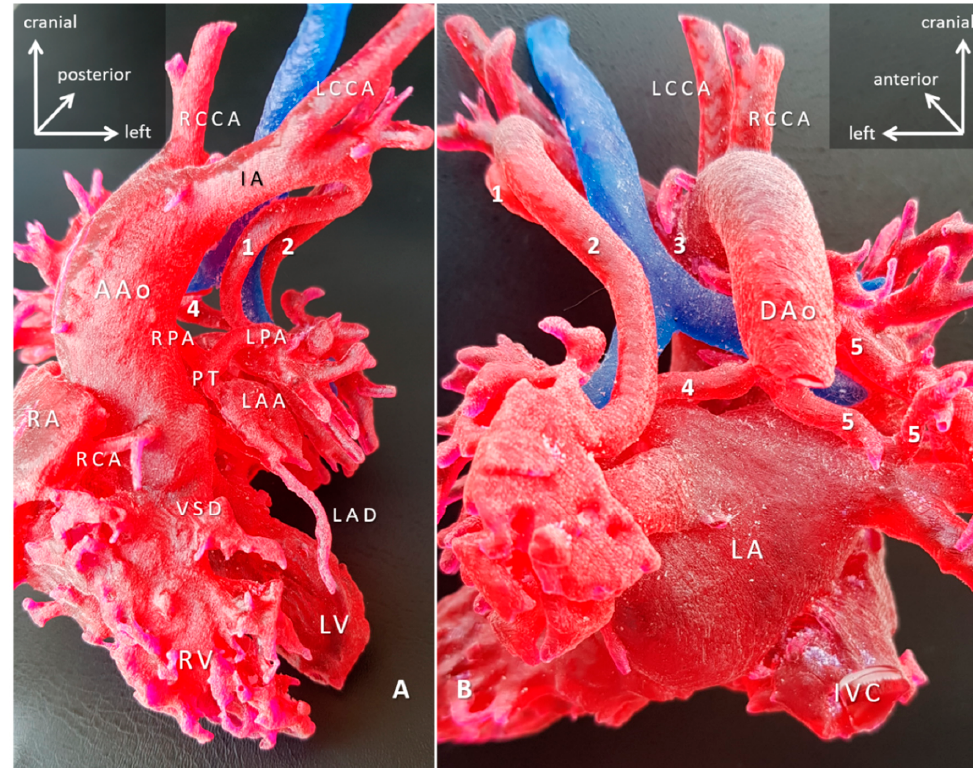
Figure 7. 3D-printed blood-volume model of pulmonary atresia, VSD and major aortopulmonary collaterals arteries (MAPCAs); right aortic arch (Case 7). Blood-volume model printed in red, and trachea printed in blue to give anatomical reference. ( A ) Anterior view; ( B ) posterior view. The right ventricle outflow tract is missing, and the native pulmonary arteries are hypoplastic. The pulmonary circulation entirely depends on the MAPCAs (1–5). The surgical task is paramount that involves reconstruction of the intrapericardial pulmonary arteries by unifocalization of all five MAPCAs and con- necting them to the right ventricle via a preferably valved and growing conduit, with/out closure of the VSD. The surgical plan was worked out in detail with the 3D-printed model. Abbreviations: AAo: ascending aorta; DAo: descending aorta; IA: innominate artery; IVC: inferior vena cava; LA: left atrium; LAA: left atrial appendage; LAD: left anterior descending branch of the left coronary artery; LCCA: left common carotid artery; LPA: left pulmonary artery; LV: left ventricle; PT: pulmonary trunk; RA: right atrium; RCA: right coronary artery; RCCA: right common carotid artery; RPA: right pulmo- nary artery; RV: right ventricle; VSD: ventricular septal defect. Accuracy of the 3D virtual models showed exact matching with the CT-dataset they were based on. Accuracy depended on two factors, manual segmentation for the virtual model and 3D printed resolution for the printed model, which was always better than imaging resolution. 3D-printed models were then validated by comparing the diameters of the inferior vena cava and ascending aorta from the CT scan and comparing with those from the blood volume 3D-printed model (data were extrapolated for the scaled proto- types). No significant difference was found between CT scans, the virtual, and 3D-printed models. The 3D-printed prototypes were also evaluated with the intraoperative findings,